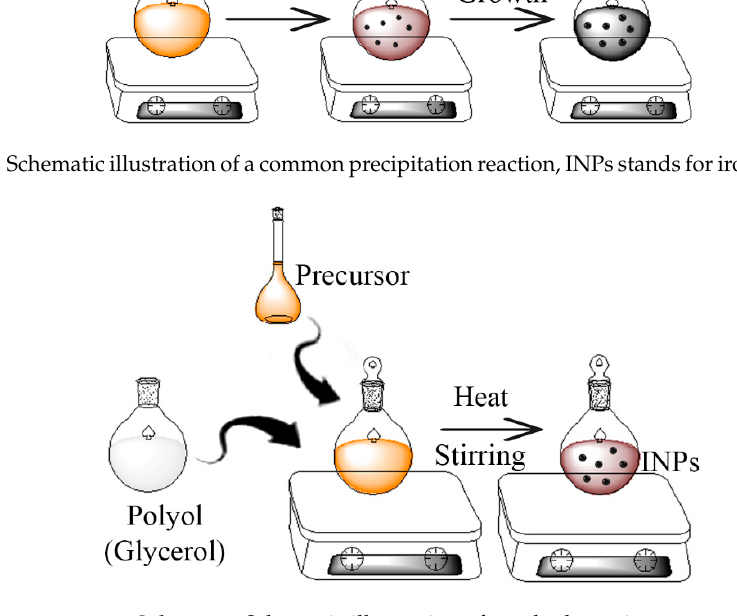
Scheme 3. Schematic illustration of a pyrolysis reaction. Scheme 4. Schematic illustration of hydrothermal synthesis reaction.